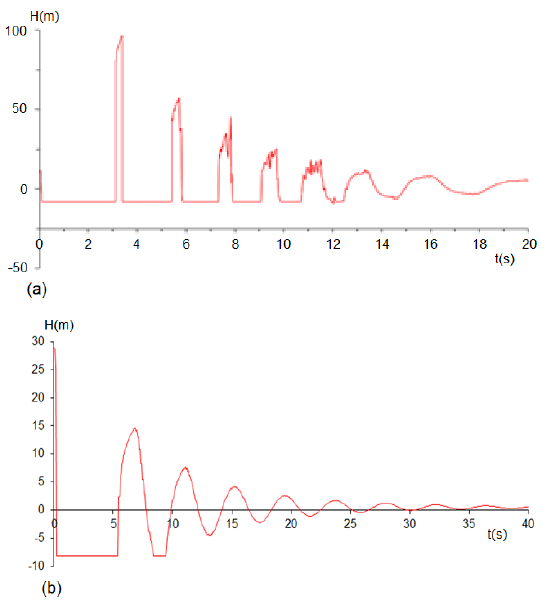
Figure 14. Cavitation occurrence and associated pressure oscillations in water pipelines: ( a ) in a metallic line; ( b ) in a plastic line.